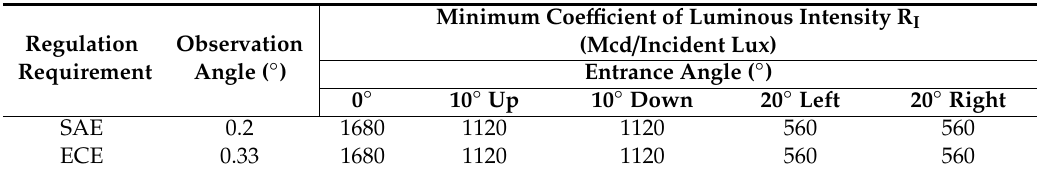
Table 1. Minimum mcd (millicandela)/incident lux for a white reflex reflector.